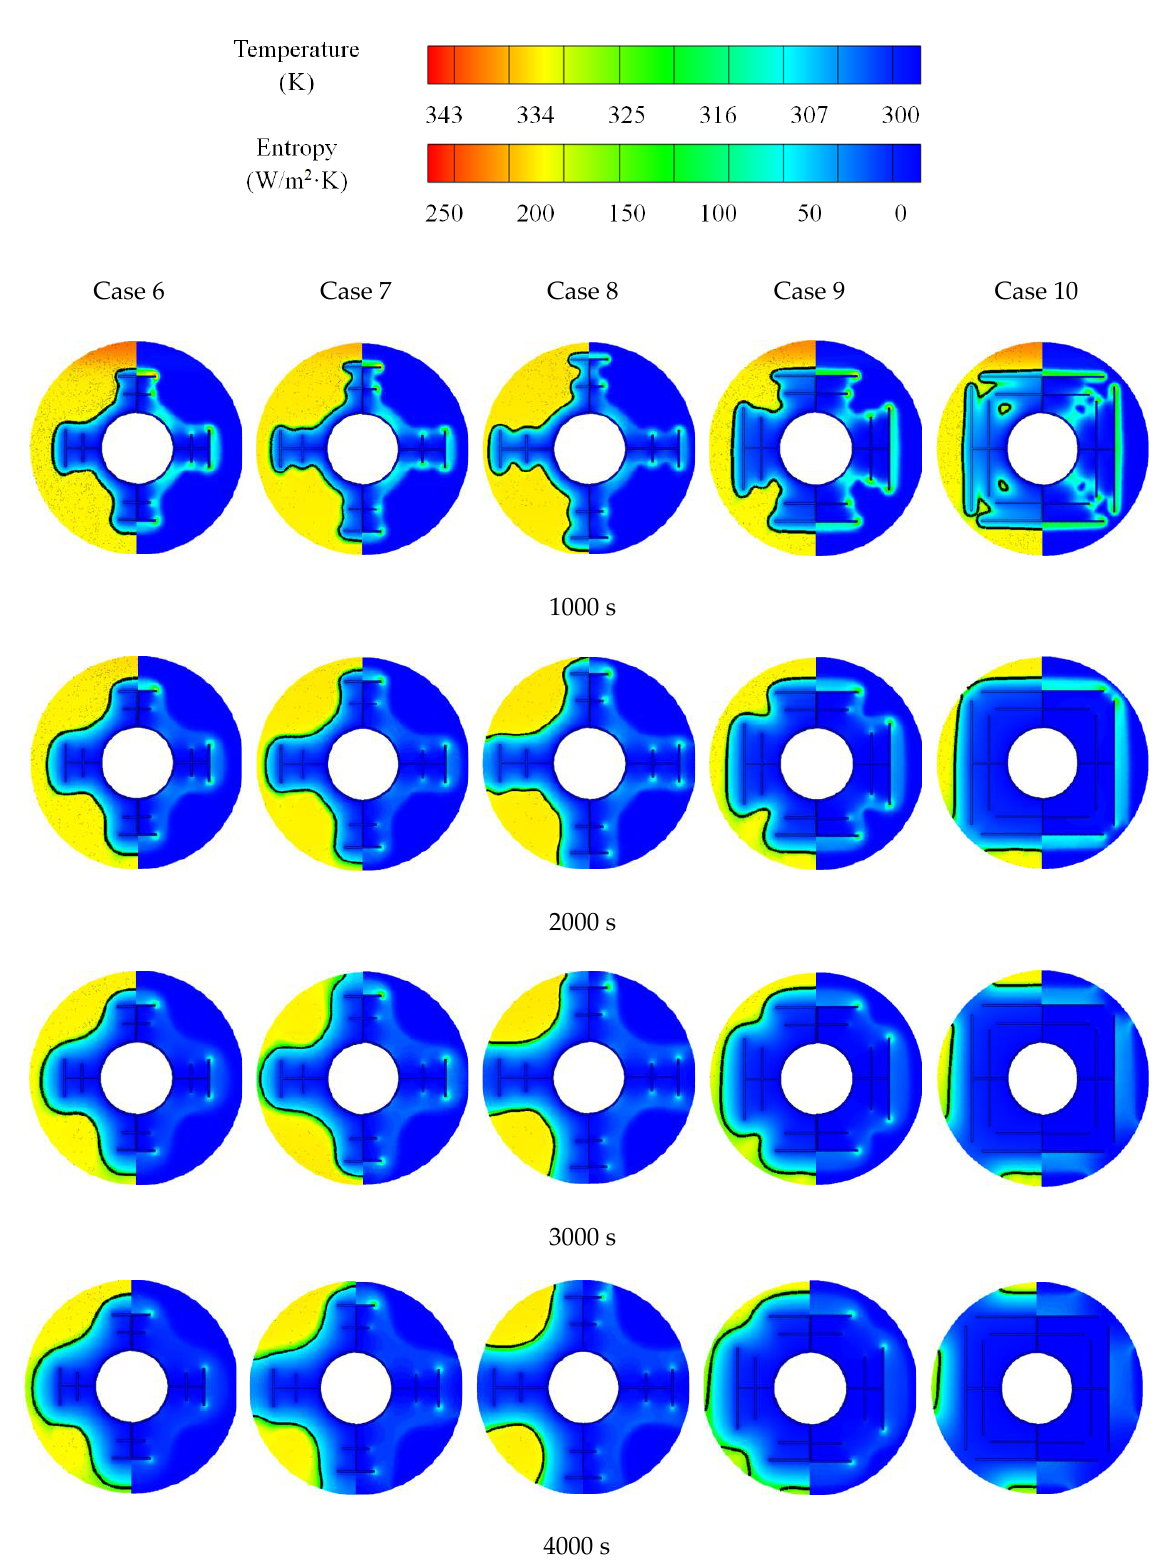
Figure 14. Solidification process for Cases 6 – 10.